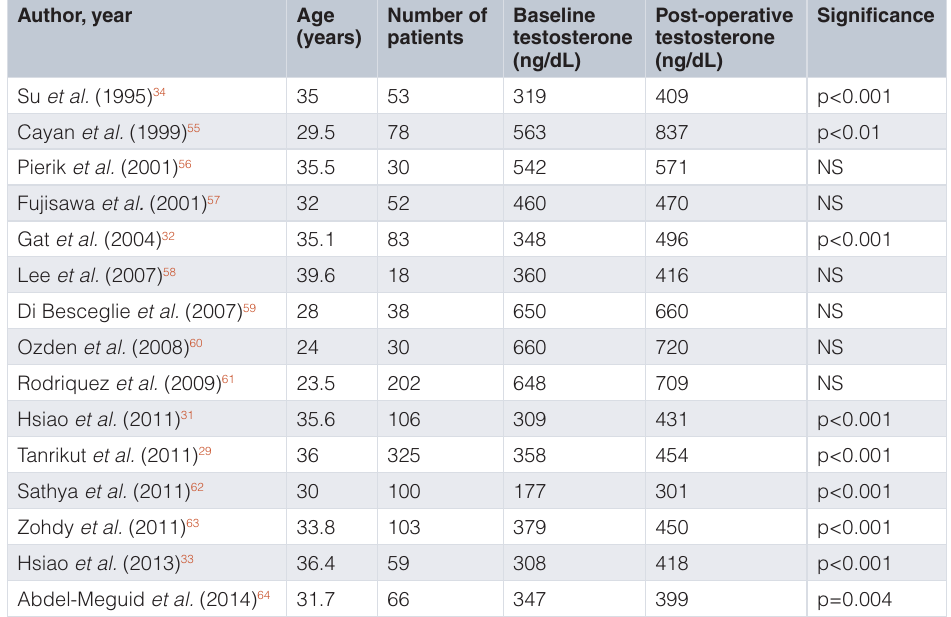
Table 1. Summary of the reported literature on varicocele repair and changes in serum